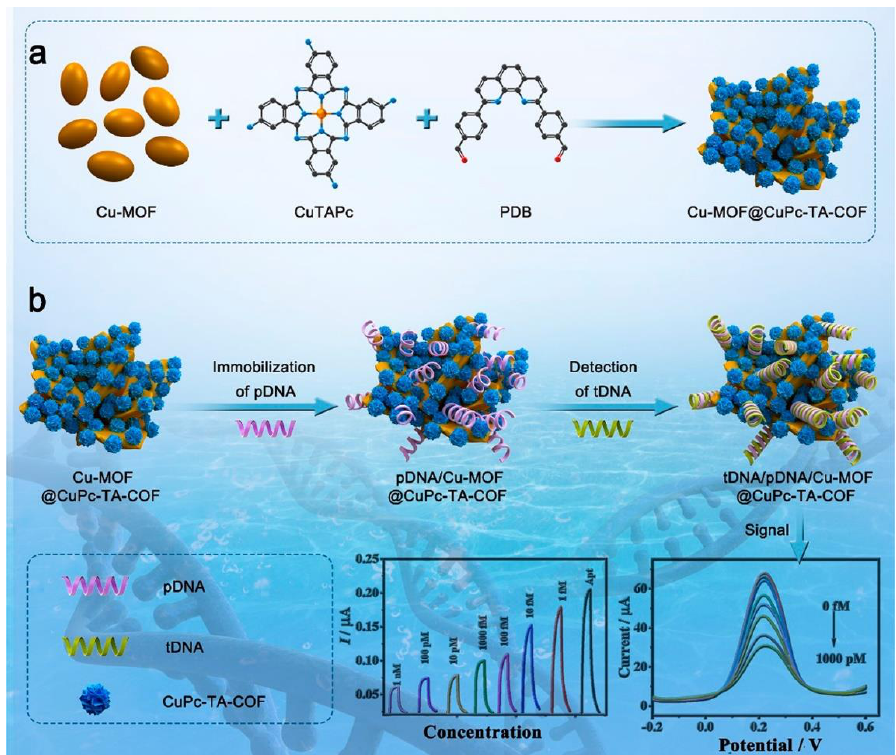
Figure 7. ( a ) Preparation of the Cu-MOF@CuPc-TA-COF Hybrid Material by the Miao Du’s re- search group [119] and ( b ) Construction Procedure of the HIV-1 DNA Biosensor Based on the Cu- MOF@CuPc-TA-COF Hybrid. Reprinted with permission from Ref. [119]. Copyright 2021 American Chemical Society.